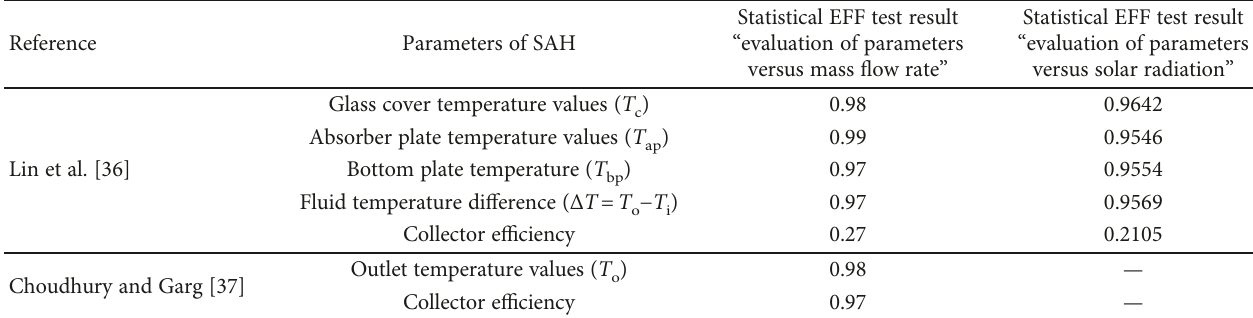
Figure 15: Predicted outlet temperature and e ffi ciency of the SAH obtained from the proposed mathematical model and from reference work [37]. Table 4: Accuracy of the proposed mathematical model in predicting the values of di ff erent SAH evaluation parameters for the two reference